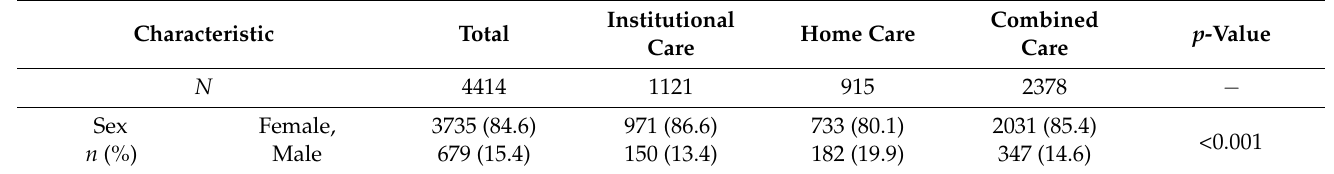
Institutional Combined p -Value Home Care Care Care